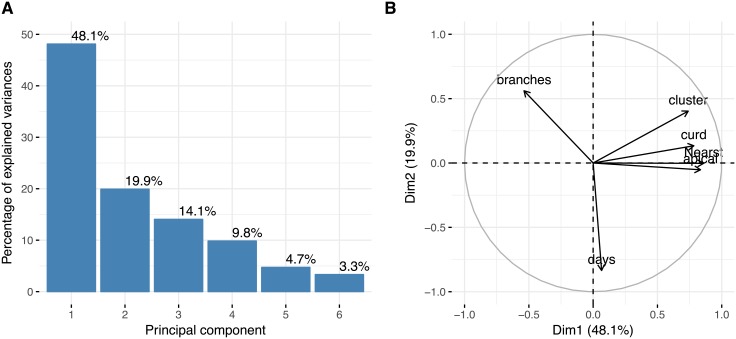
Parameters of PCA with phenotypic variation.(A) Percent variance explained by each of the six principal components. (B) Variable correlation plot on the first two principal components. The quality of traits on the PC map is expressed as distance between traits and the origin. Traits that are distant from the origin are well represented on the factor map.